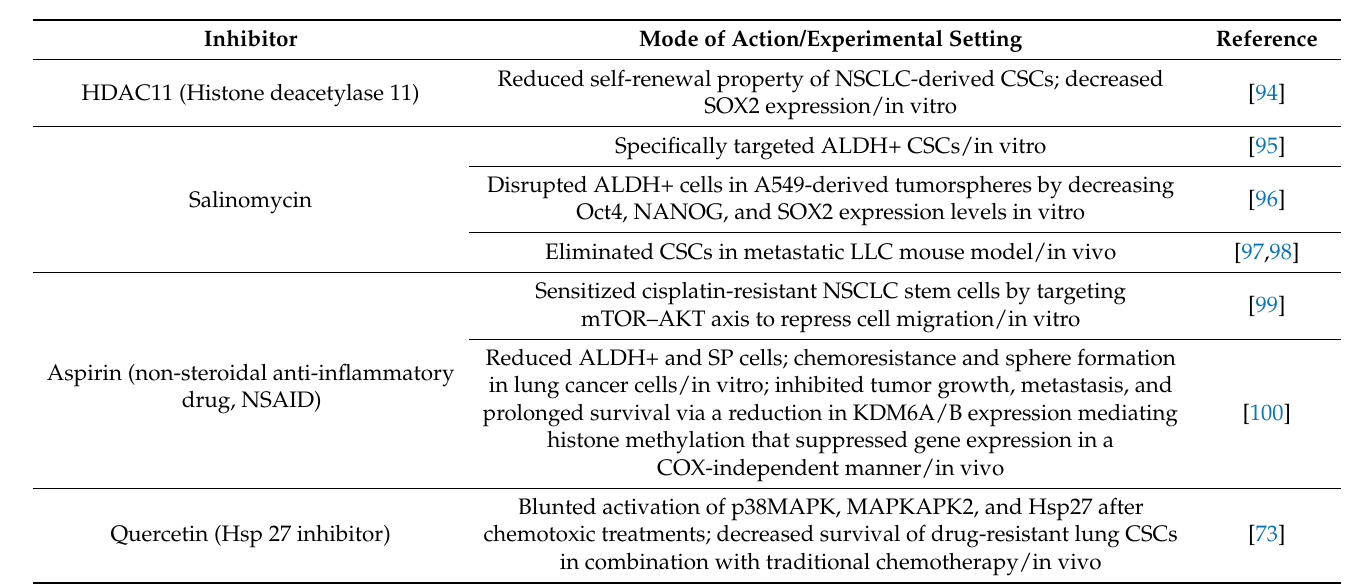
Table 1. Small molecule CSC inhibitors in lung